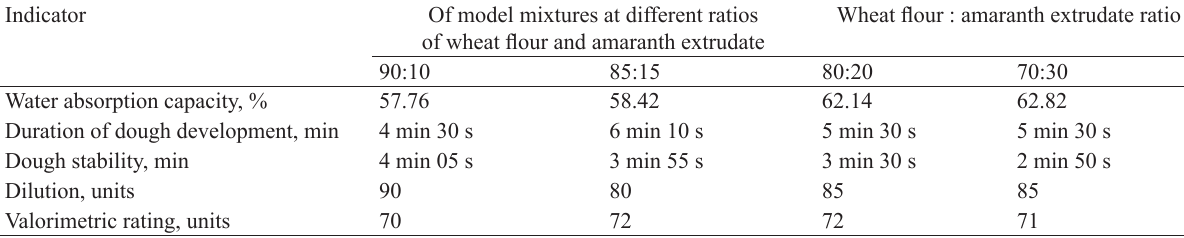
Indicator Of model mixtures at different ratios of wheat flour and amaranth